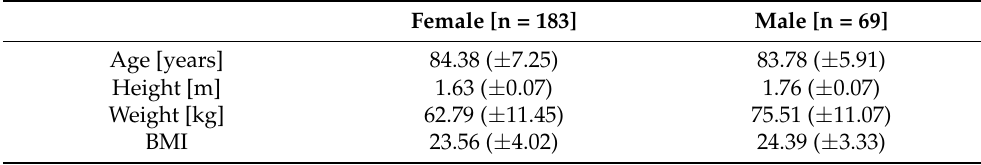
Table 1. Demographics of study population.